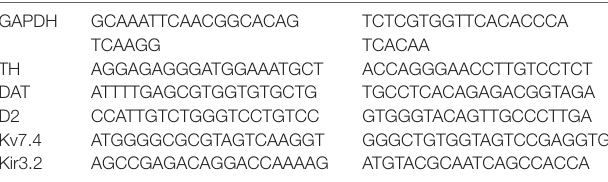
respectively); the proportions of Kir3.2-positive neurons were